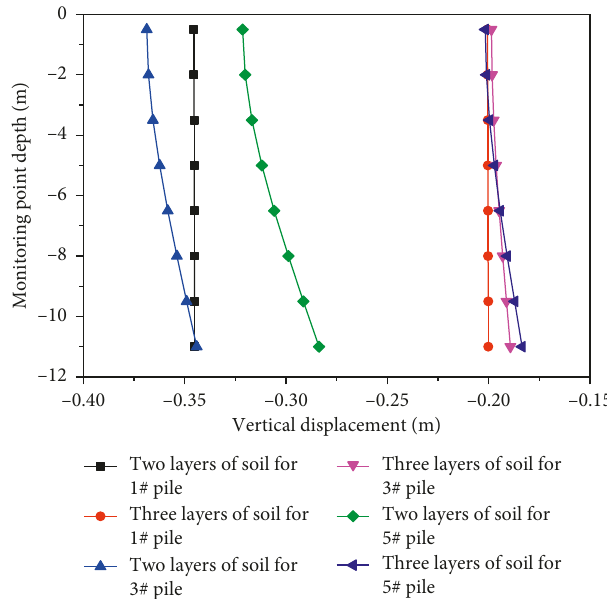
Figure 17: Comparison of the vertical displacements for different soil layers.